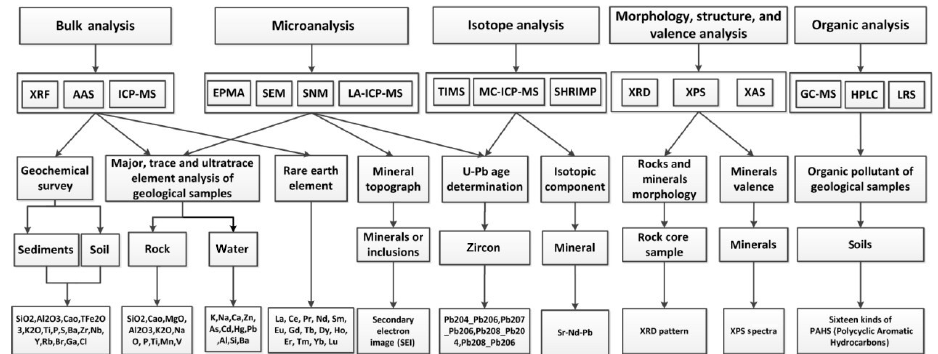
Figure 1. Process of summarizing the geoanalytical data contents.